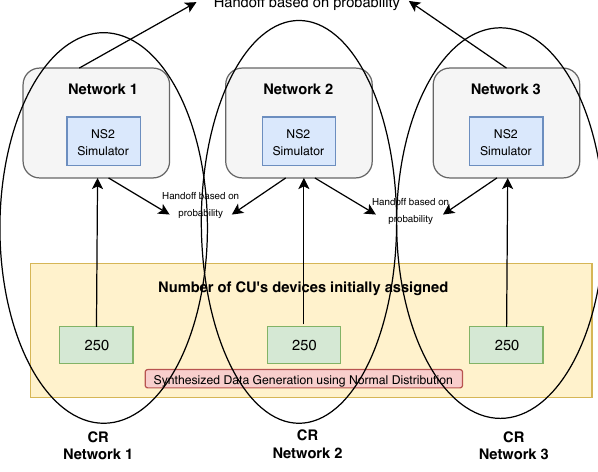
Figure 6. Testbed for the performance scrutiny of the proposed